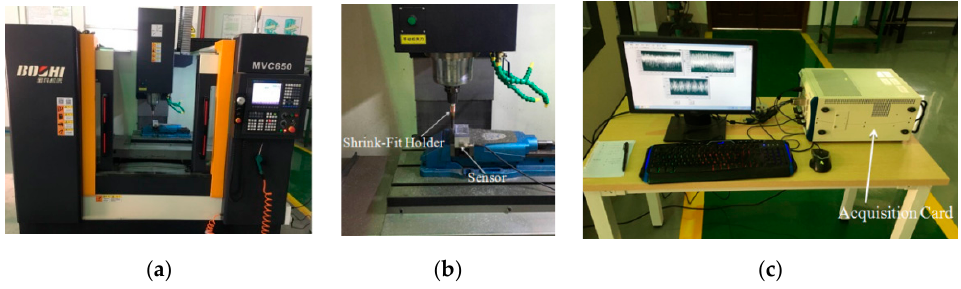
Figure 7. Milling test device diagram. ( a ) Numerical control machining center; ( b ) sensor; ( c ) acquisition card.